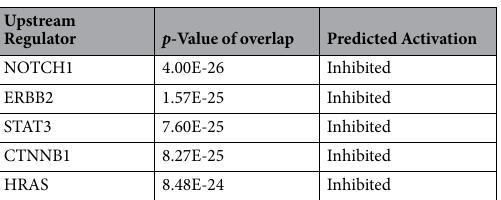
Table 1. The five top WNT pathway regulators identified by IPA and downregulated by the rs713065/C allele (see Supplementary Table 2 for IPA